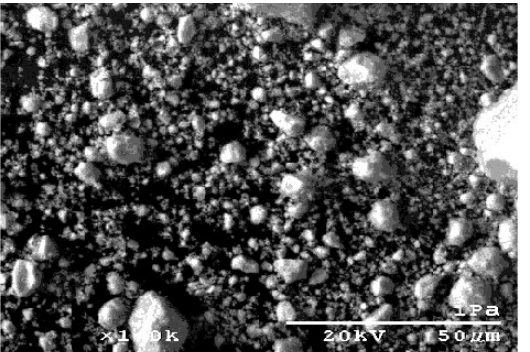
Fig. 9: SEM micrograph of the pure Pglass powder used in making the hybrids with organic